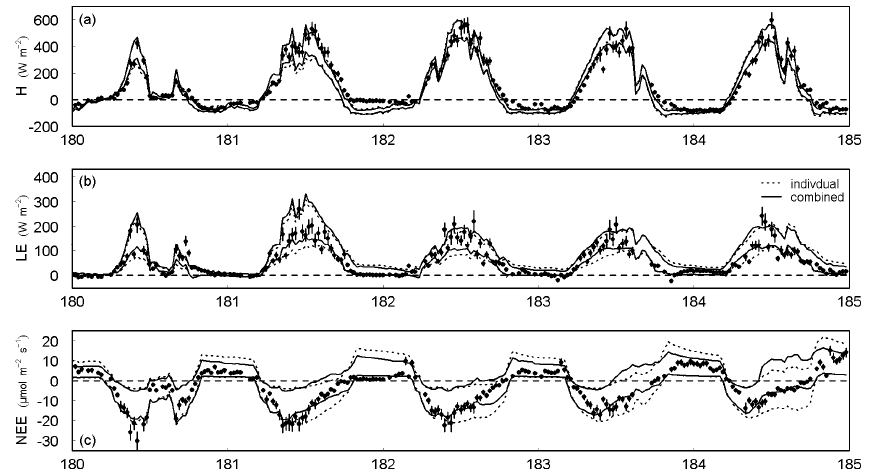
Fig. 8. Predictive uncertainty bounds (5th and 95th quantile) and observed values (black dots) for the sensible heat flux, H, (a) , the latent heat flux, LE, (b) , and the net ecosystem exchange, NEE, (c) , for the coefficient of efficiency (IOP-2, dotted lines: individual best 10%, solid lines: combined). Vertical lines display the error after Mauder et al. (2006) depending on the quality flag. For sensible heat fluxes, the error is 10% for quality classes 1-3 and 15% for quality classes 4-6. For latent heat fluxes and the NEE, the error is 15% for quality classes 1-3 and 20% for quality classes 4-6 according to Foken et al. (2004).